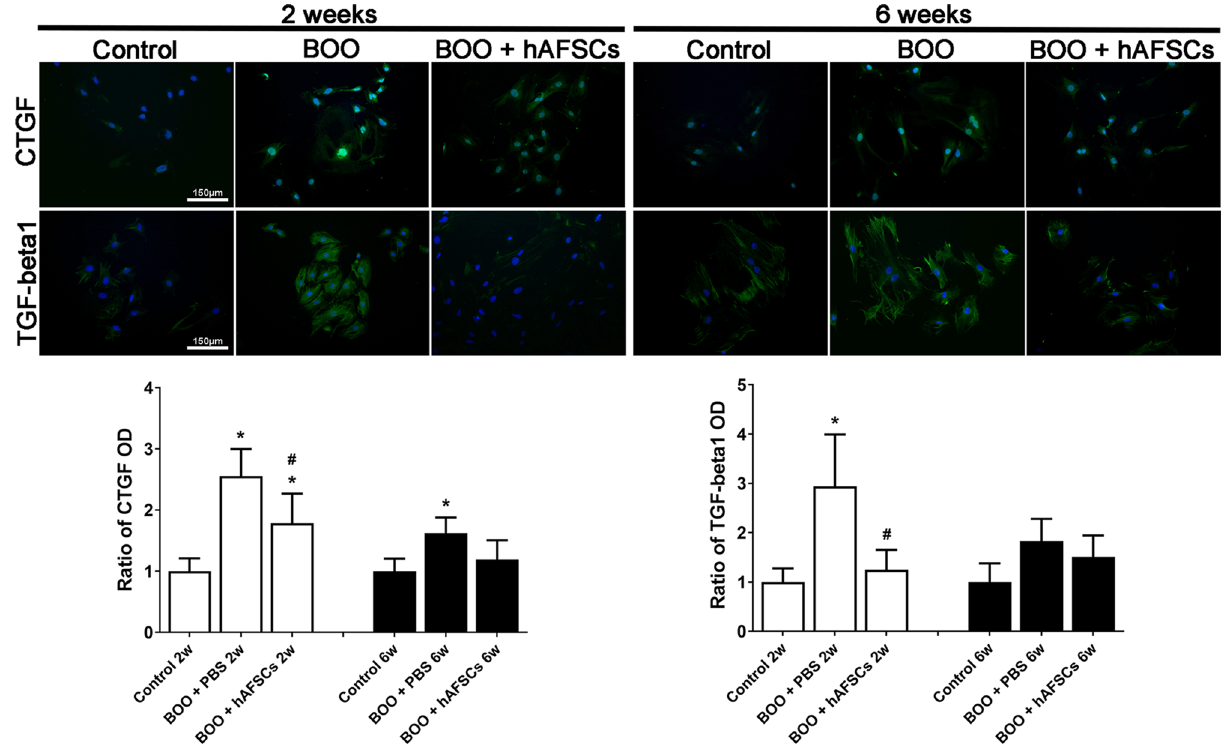
Figure 7. Temporal immunofluorescent expressions of CTGF and TGF-β1 in cultured detrusor cells of control, pBOO + PBS and pBOO + hAFSCs. Compared with the control, cultured detrusor cells of pBOO rat have higher CTGF immunoreactivity at 2 and 6 weeks after pBOO, and higher TGF-β1 immunoreactivity at 2 weeks after pBOO. All these changes can be improved after hAFSCs treatment. *: P < 0.05 vs. control, #: P < 0.05 vs. pBOO + PBS. N = 6 in each time point. Bar indicates 150